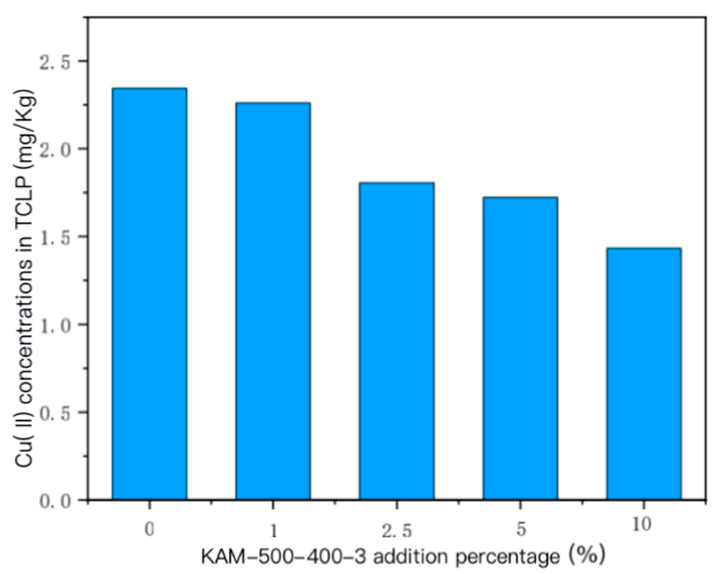
Figure 5. Cu(II) concentrations in TCLP leachates of single Cu(II)-contaminated sediment under different addition percentages of KAM500-400-3.